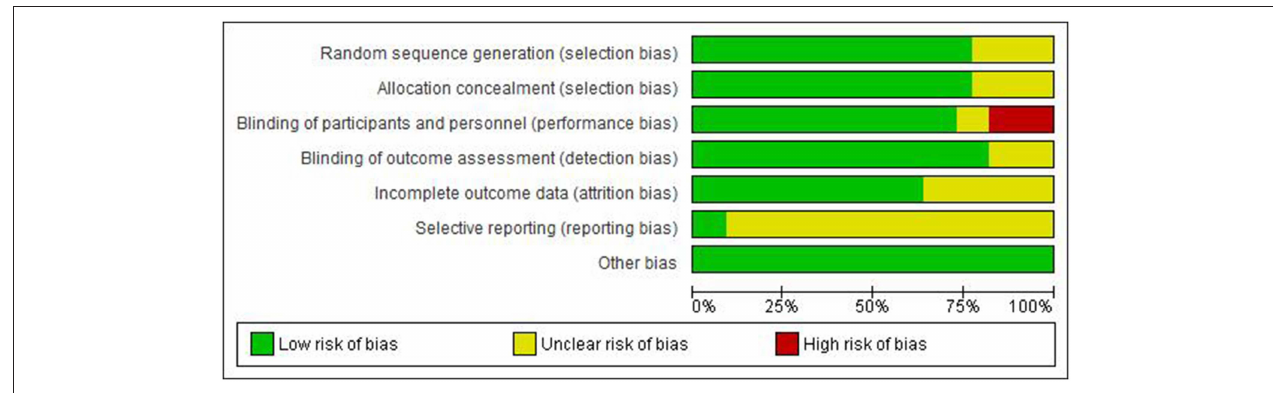
FIGURE 6 | Risk of bias across clinical